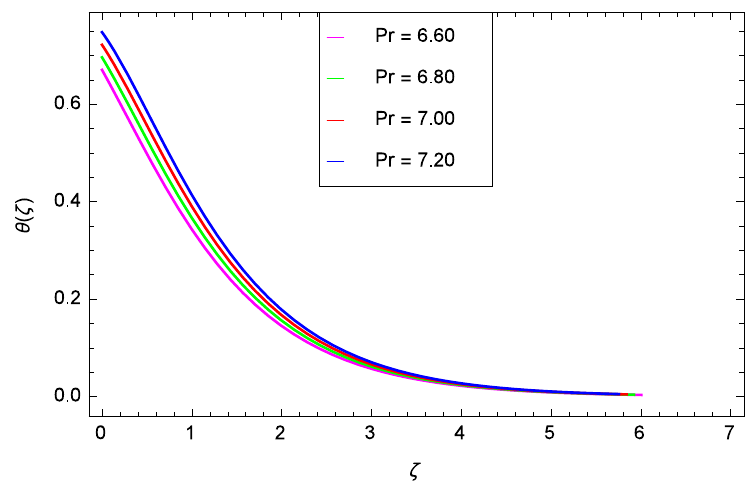
Figure 16. Influence of Pr on θ ( ζ ) .